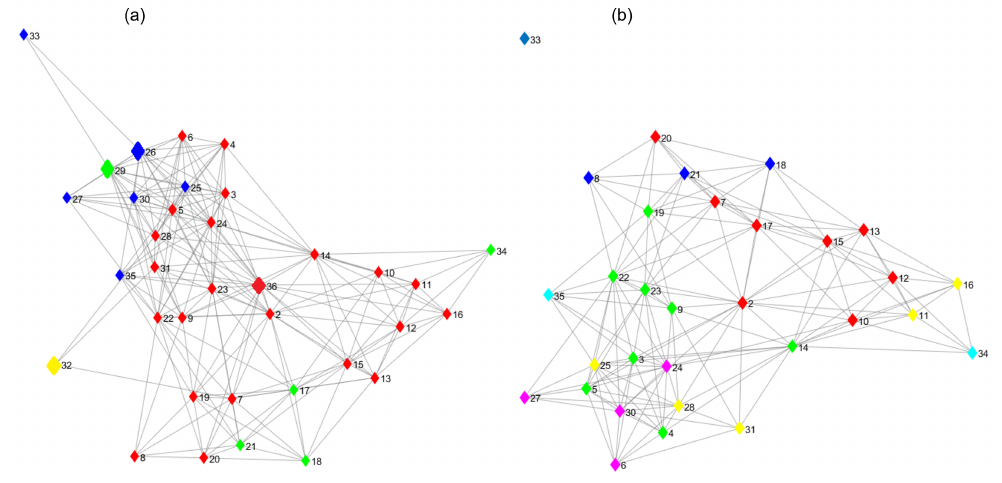
Figure 1. Steps of extracting relevant nodes by the fractal method. The nodes are distributed in four boxes, each color representing a box. ( a ) First extraction step. ( b ) Second extraction